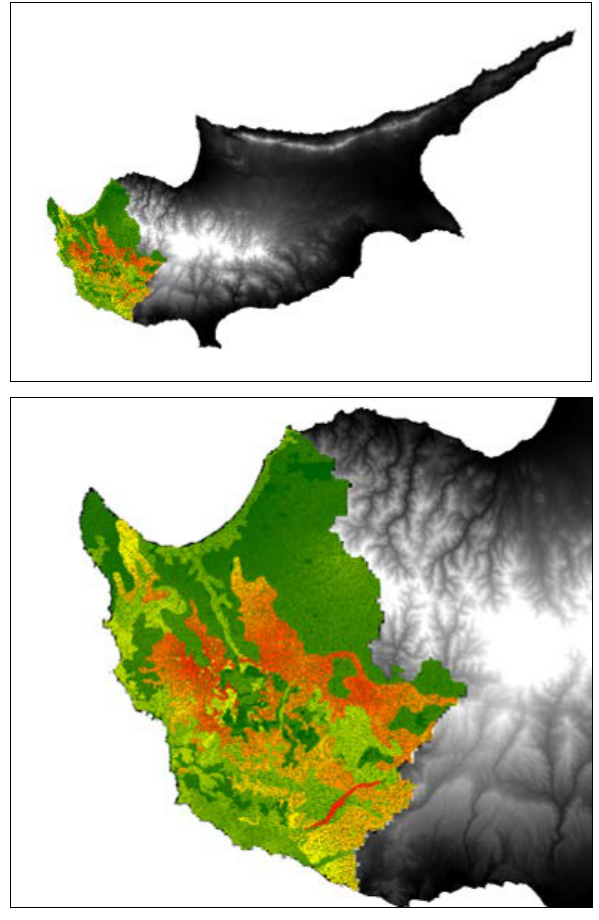
Figure 3. Map of Soil Loss estimated using RUSLE method for Paphos District over Cyprus DEM (above) and a detail